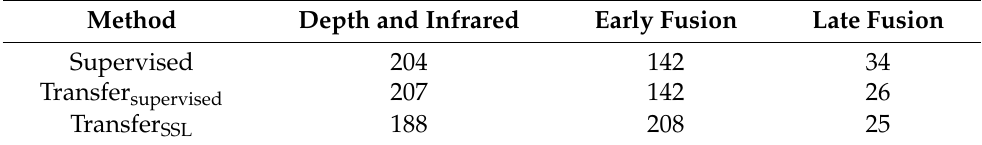
Table 6. Inference time (unit: